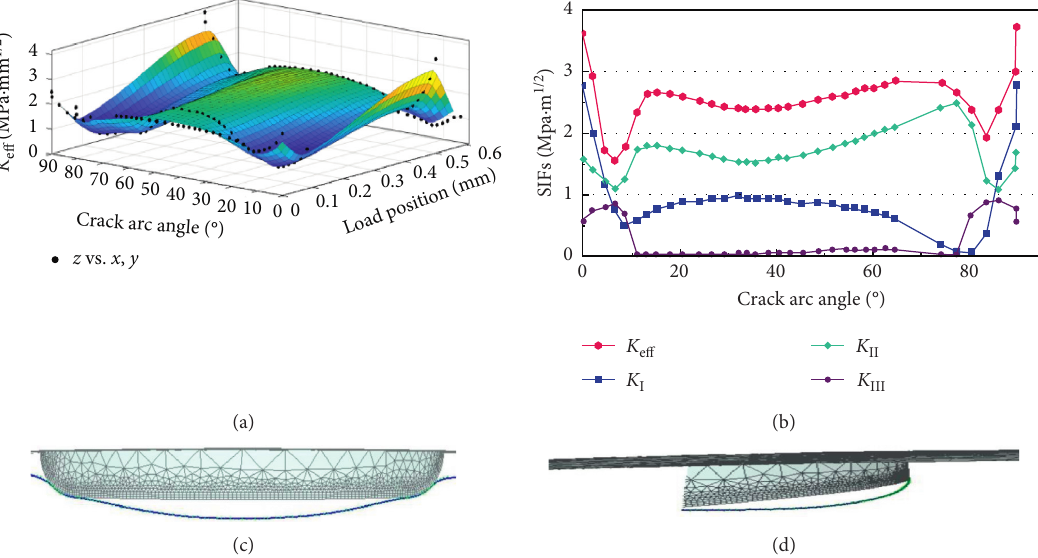
Figure 15: Related results for crack II: (a) K eff at different positions; (b) calculation of the SIFs when the load position is 0.08mm; (c) front view of crack propagation; (d) side view of crack propagation.